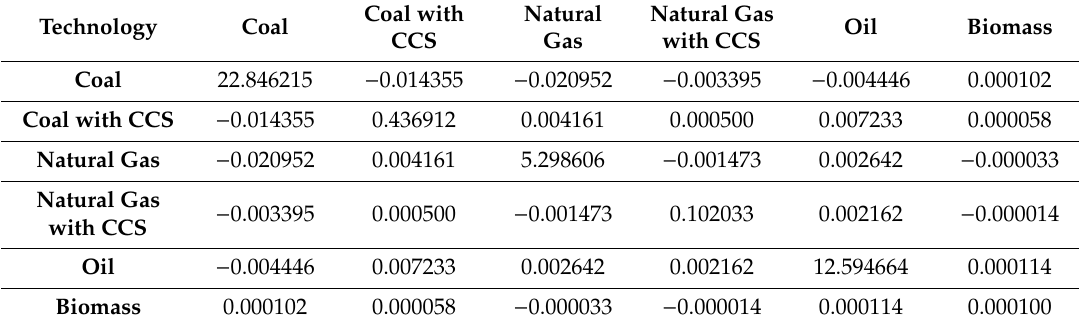
Table 5. Emission variance-covariance